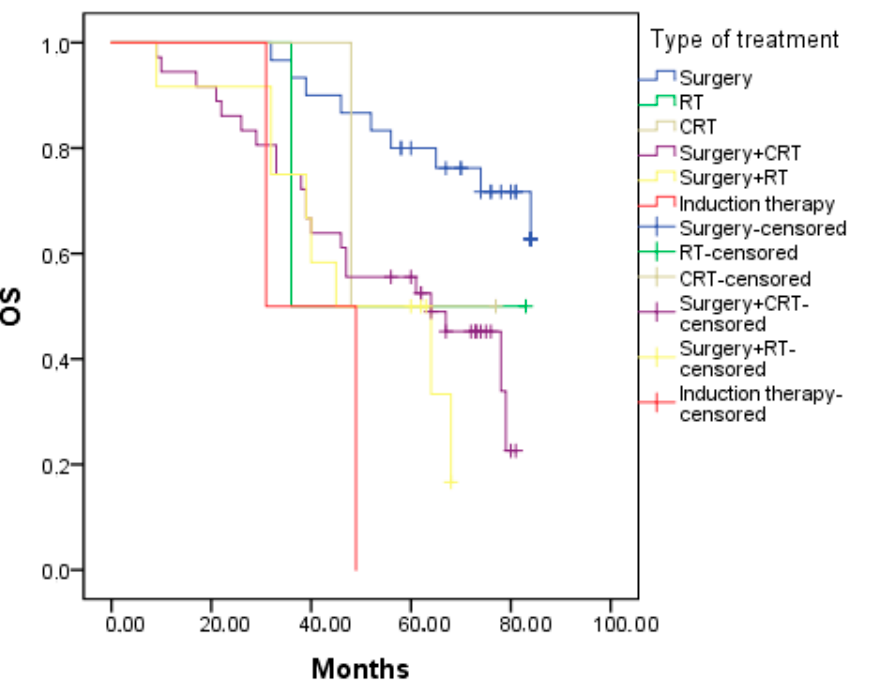
Figure 3. Kaplan–Meier curve showing OS in different treatment groups, log-rank p = 0.009. Table 3. Survival for di ff erent treatment groups.